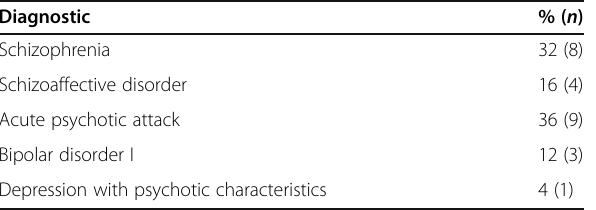
Table 2 Patients diagnosis